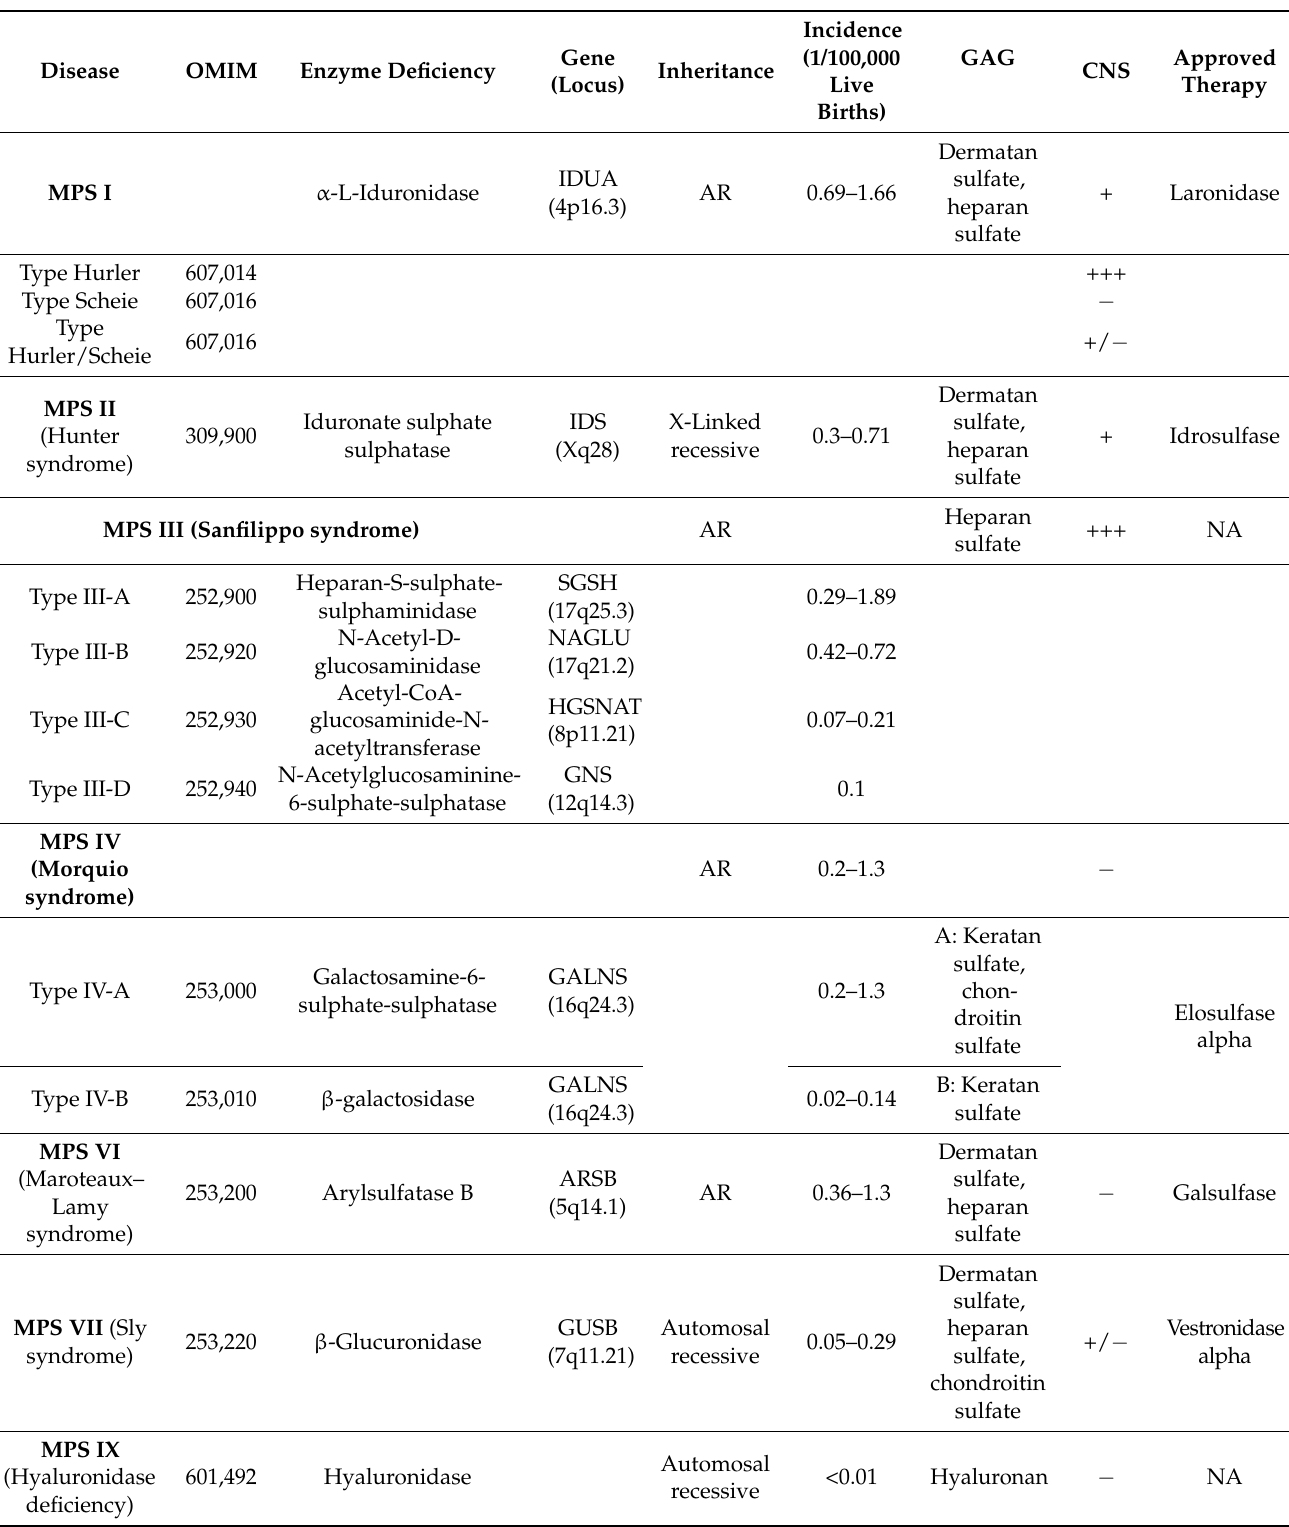
Table 1. Genetical and demographical features of